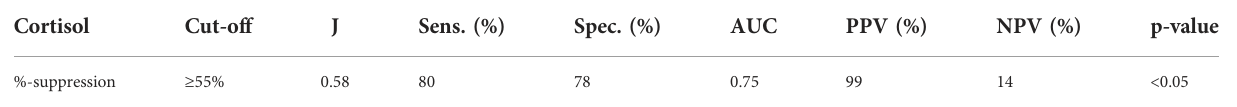
TABLE 4 Diagnostic outcome of the overnight 8 mg dexamethasone suppression